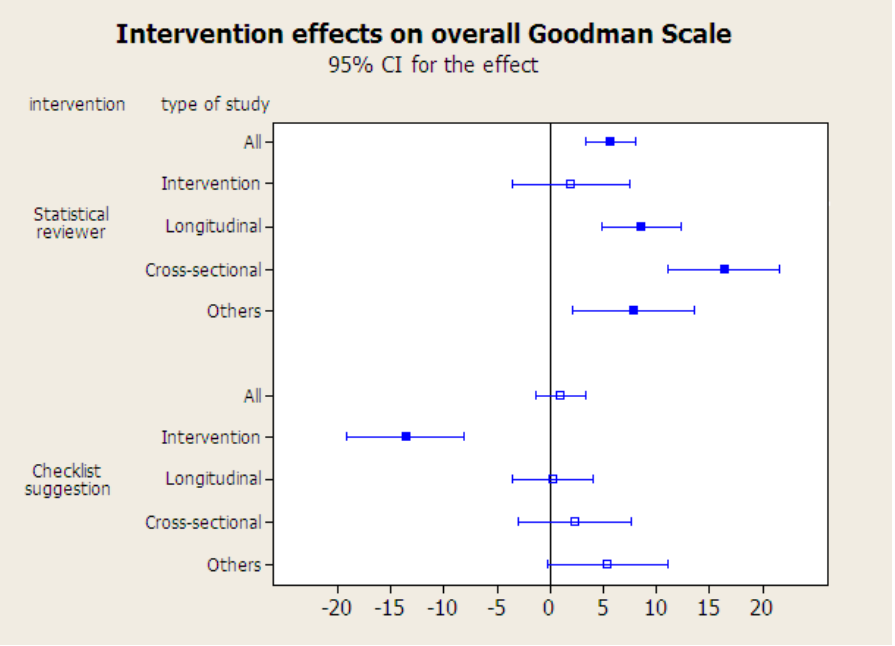
Figure 3. Intervention effects on overall Goodman Scale. Solid boxes indicate statistically significant effects.